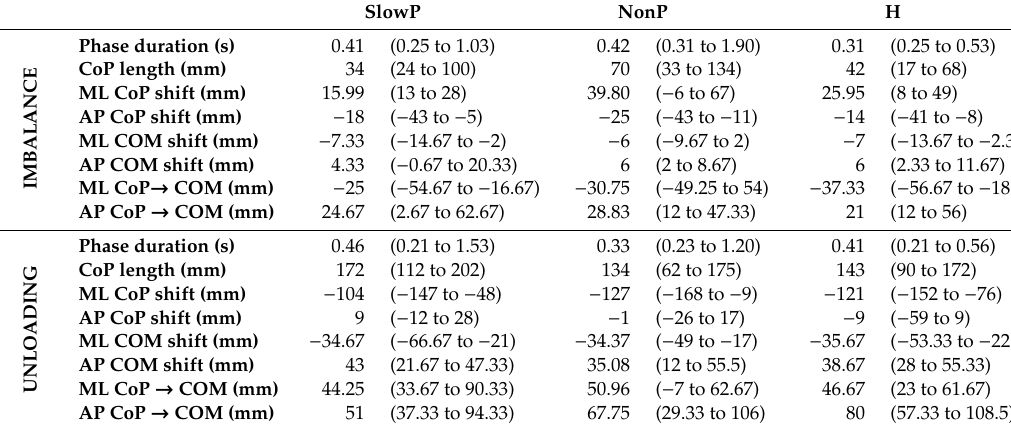
Table 3. Postural parameters during the imbalance and unloading phases. Data are shown as median value (range) for children with slow progressive PCA (SlowP), children with non-progressive PCA (NonP), and healthy children (H). ML: mediolateral, positive towards the swing foot; AP: anteroposterior, positive when forwards; CoP → COM: horizontal distance from CoP to COM. SlowP